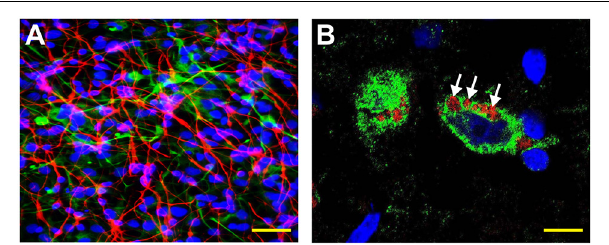
FIGURE 1 | Human neuronal-glial (HNG) cells (transplantation grade) in primary co-culture were used to study the dynamics of amyloid-beta 42 (A β 42) peptide-mediated entry of lipopolysaccharide (LPS) into neurons (Bhattacharjee and Lukiw, 2013; Zhan et al., 2018; Zhao and Lukiw,